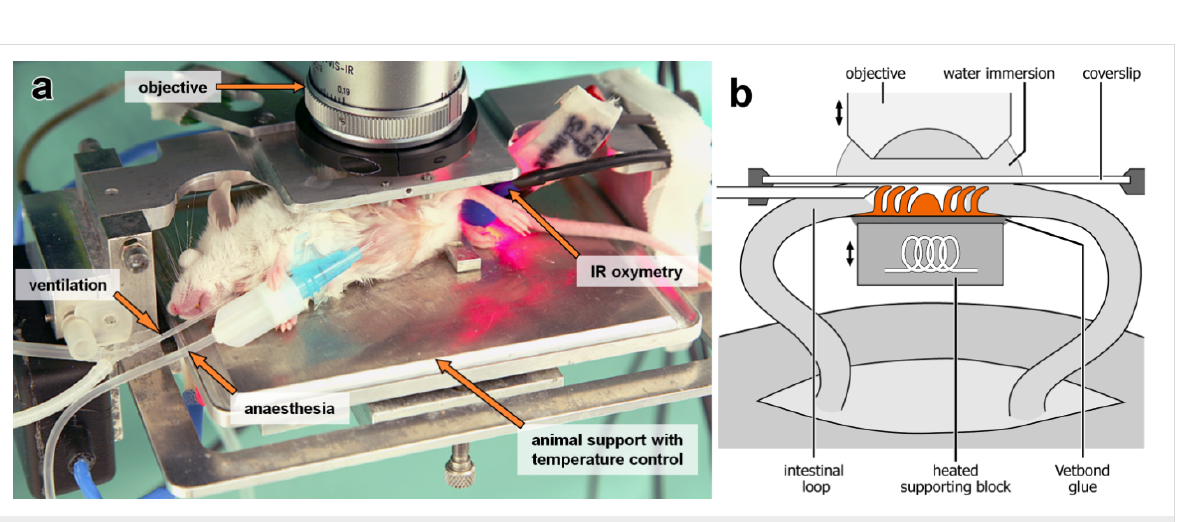
Figure 9: a) Anaesthetized Balb/c mouse on a homeothermic table with an exteriorized ileal loop. b) Schematic diagram of the chamber for intravital 2PM imaging.